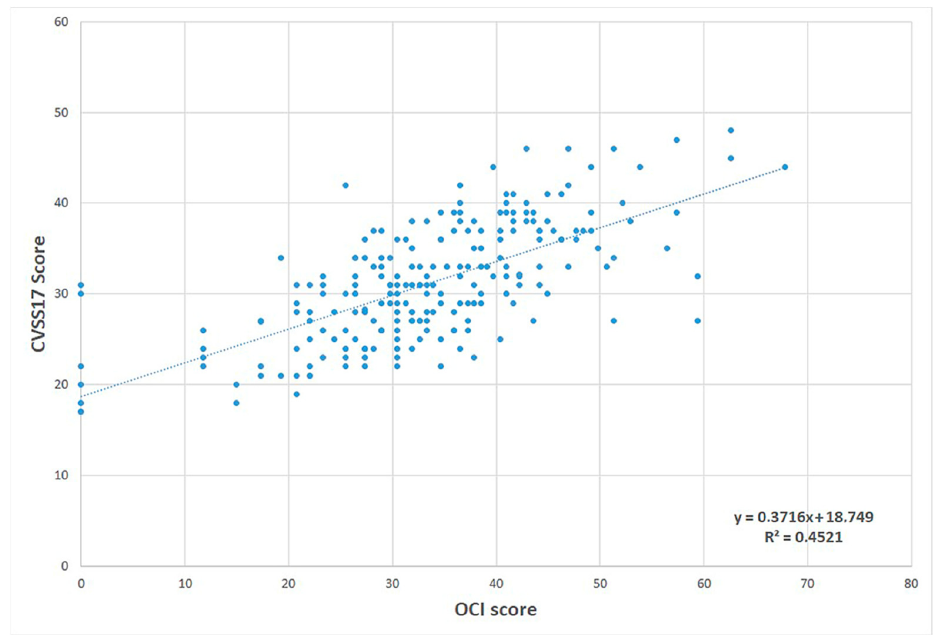
Figure 3. Scatterplot of correlation between the OCI VE and CVSS17.